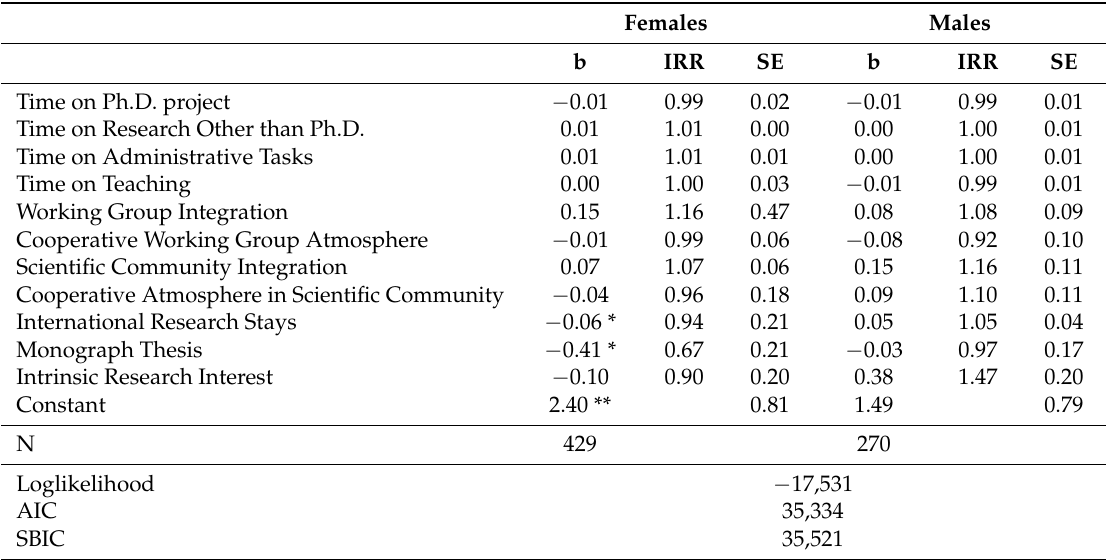
Table 3. Factors Associated with Co-Authored Publications for Females and